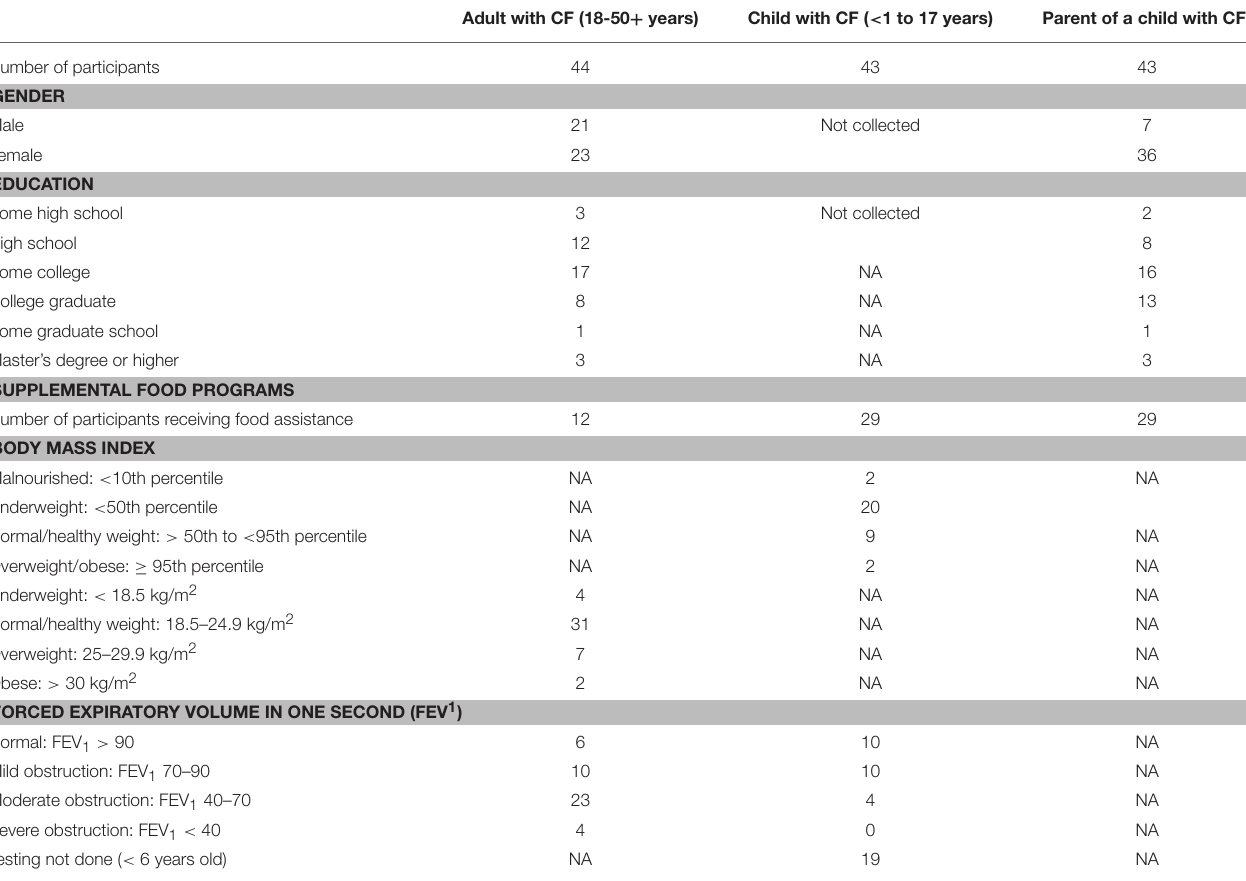
TABLE 1 | Demographics of study patients with cystic fibrosis. Adult with CF (18-50 + years) Child with CF ( < 1 to 17 years) Parent of a child with CF * Number of participants 44